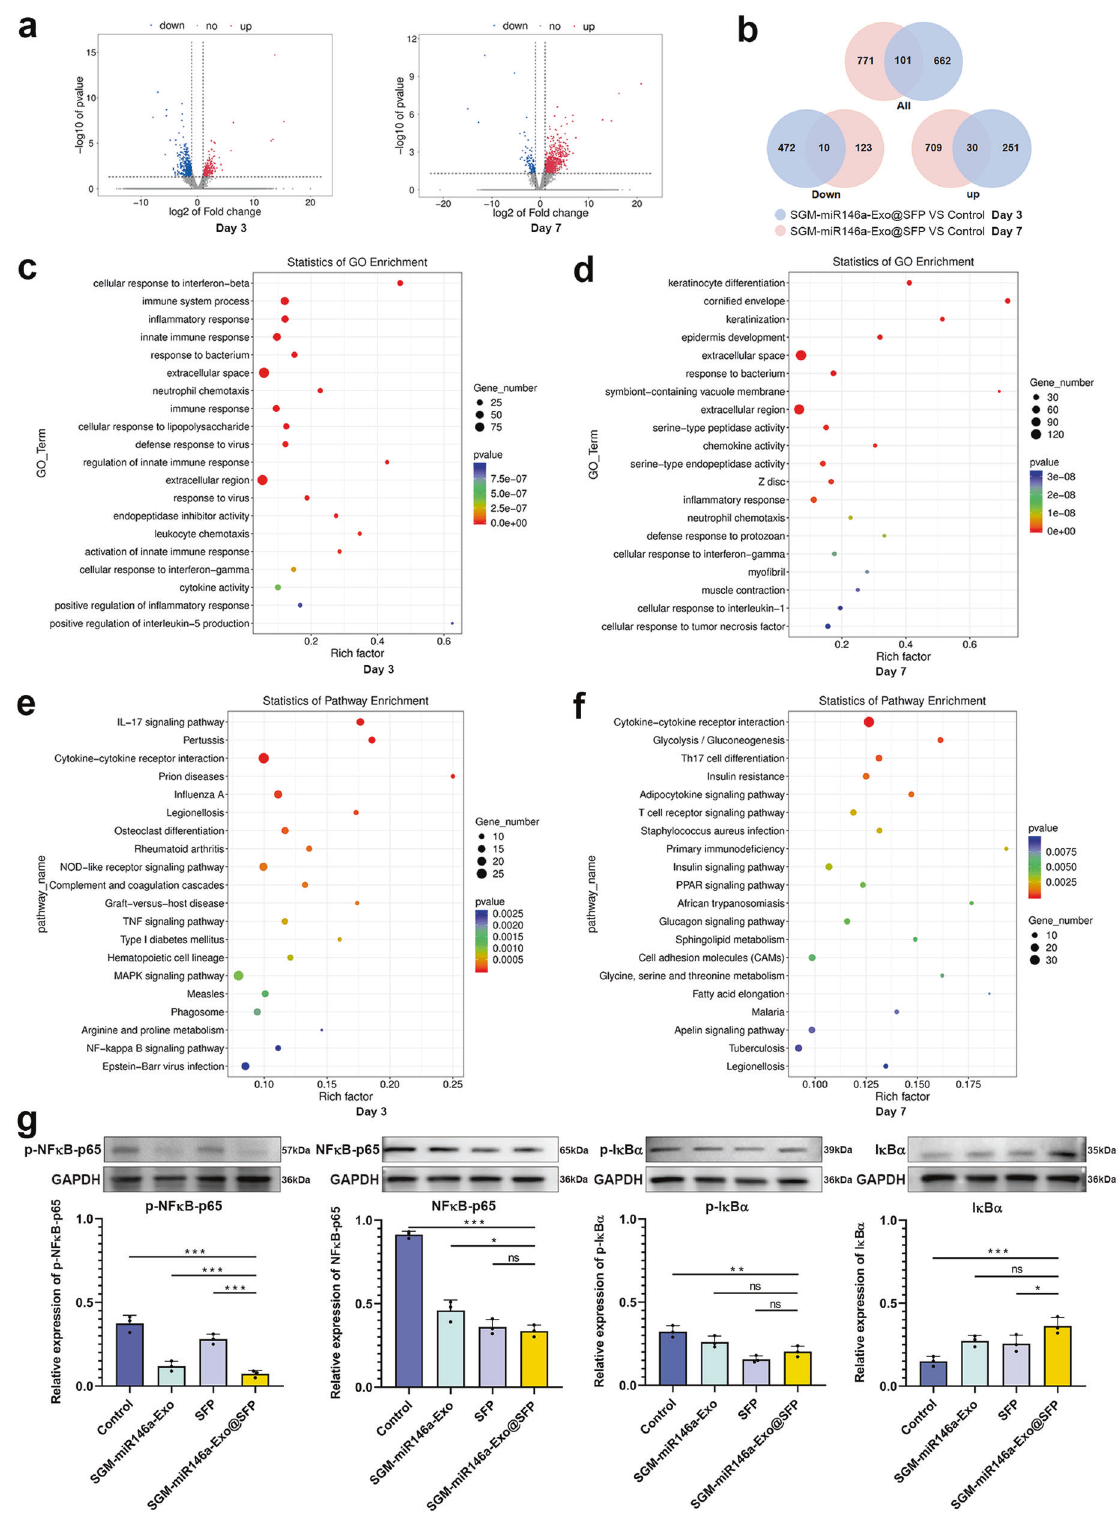
Fig. 8 Transcriptomics analysis of the wound tissue and con fi rmation experiment of the in fl ammation signaling pathways. a Volcano plot of differentially expressed genes (DEGs) at day 3 and day 7. b Venn diagram of two overlapping circles representing the overlapped down and up genes at day 3 and day 7. c Gene Ontology (GO) enrichment analysis of DEGs. d DEGs at day 7 were enriched in skin development and differentiation. e KEGG pathway enrichment analysis of DEGs. f SGM-miR146a-Exo@SFP upregulated insulin pathway and cell adhesion molecule (CAM) pathway at day 7. g The expressions of p-NF κ B-p65, NF κ B-p65, p-I κ B α , and I κ B α in wound tissue. Data represent the mean ± S.D. of three different experiments (ns, no signi fi cance, * p < 0.05, ** p < 0.01, *** p < 0.001)